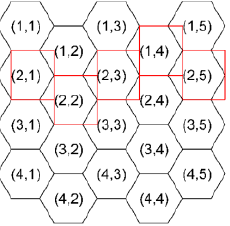
Figure 1. Hexagonal grid cell coordinates and candidate’s rows and columns (red rectangles).